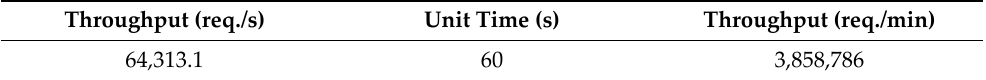
Table 8. Test results during 10 times of